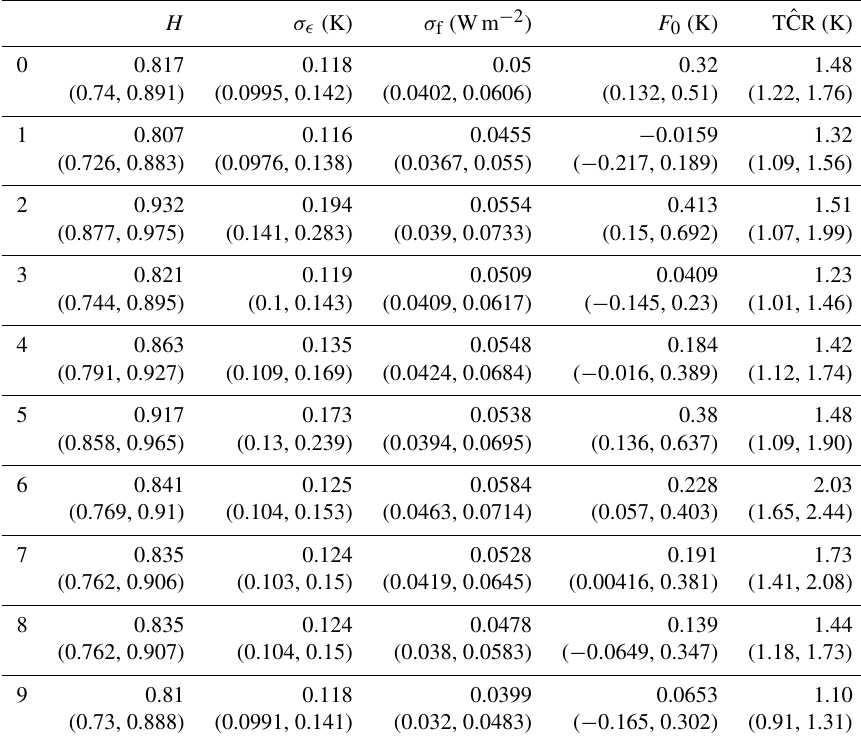
Table 5. This table contains marginal posterior means and 95% credible intervals for the model parameters and the transient climate response obtained from fitting the scale-invariant response model to the HadCRUT dataset using forcing data from Hansen et al. (2010) (denoted by ID 0) and from the first nine